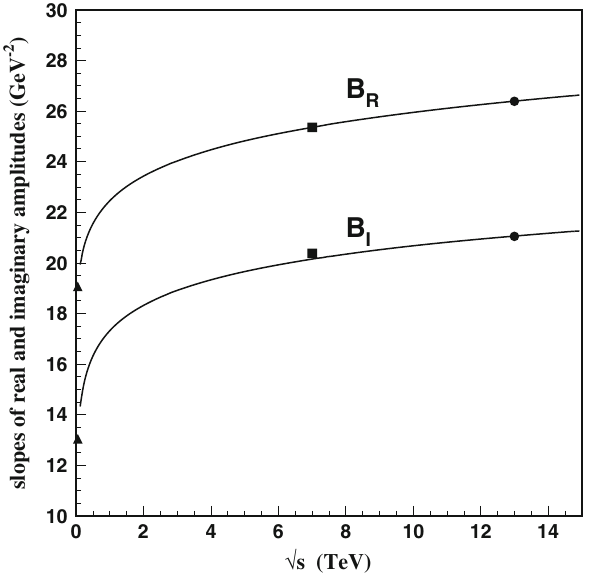
Fig. 11 Energy dependence of the slopes of the real and imaginary amplitudes